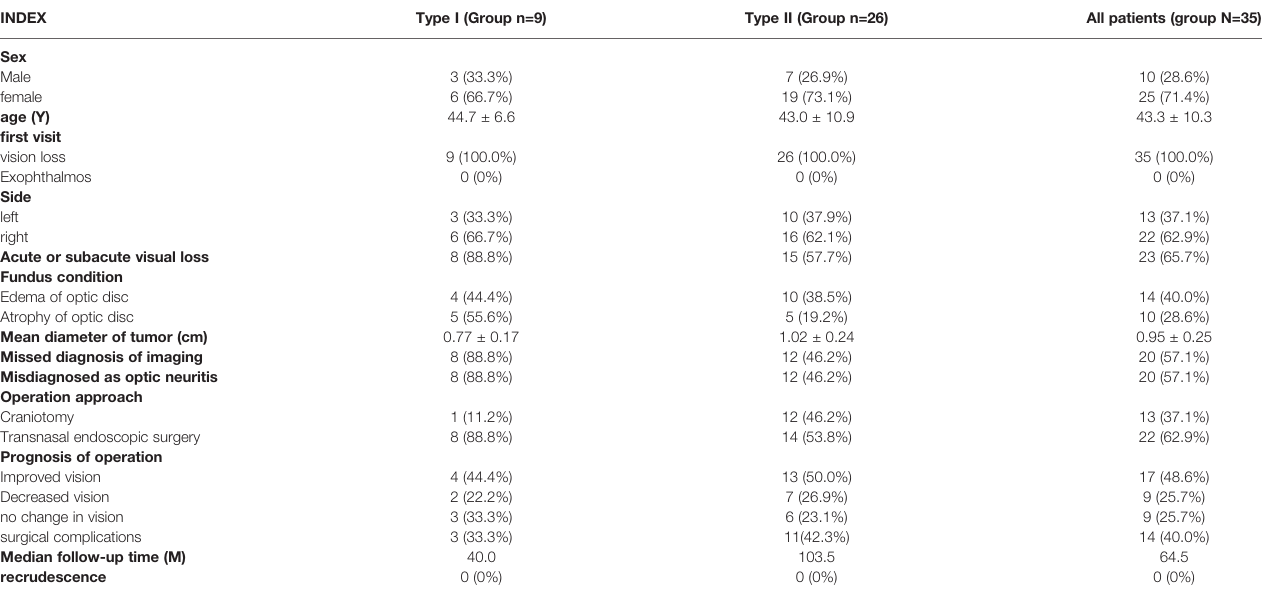
TABLE 1 | Clinical characteristics and surgical prognosis of type I and type II cavernous